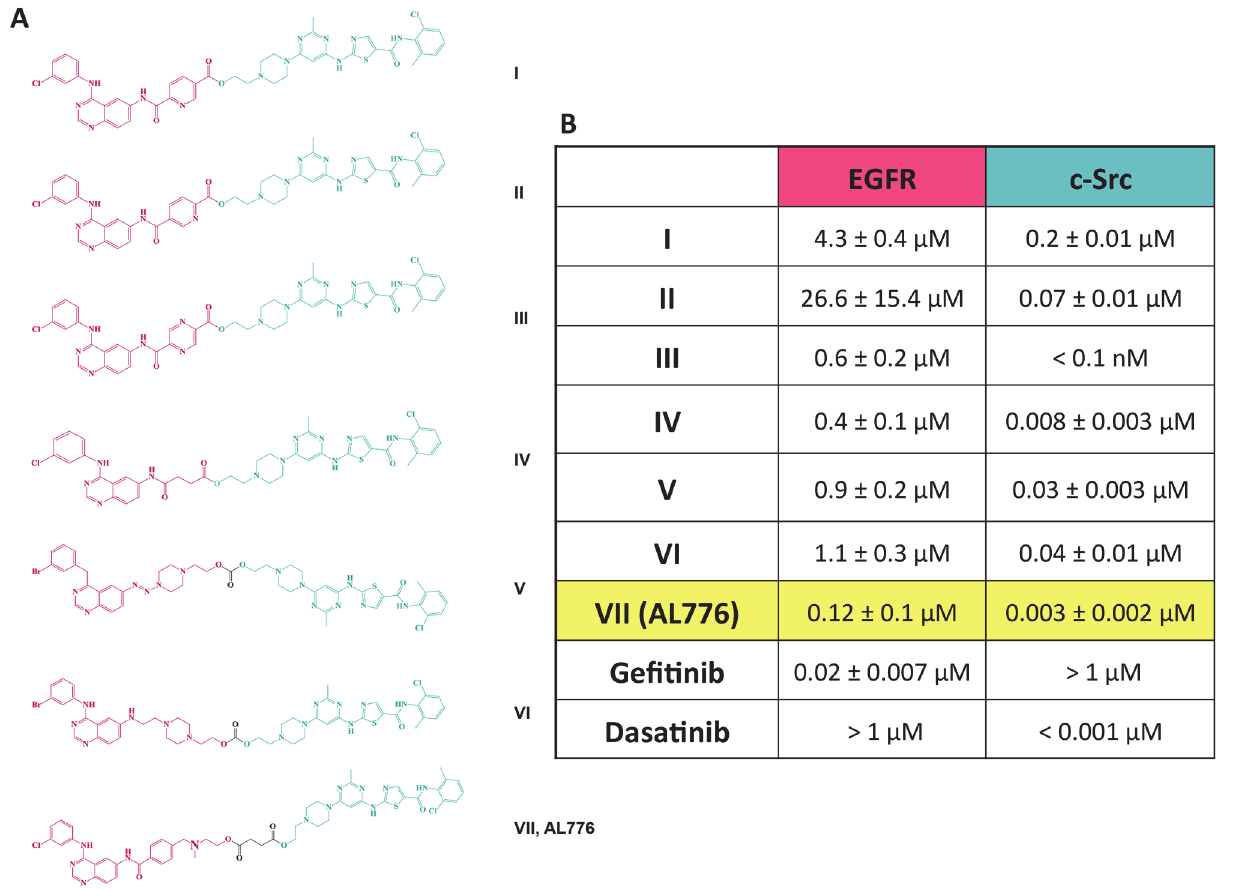
Fig 2. Series of EGFR-c-Src targeting type III molecules and their kinase inhibitory potency in vitro . ( A ) EGFR-c-Src targeting type III molecules were designed and synthesized in our laboratory using quinazoline moieties (red) as the EGFR targeting head and dasatinib as the c-Src inhibitory arm (green), connected through different hydrolysable linkers. ( B ) In vitro kinase assay was used to determine the potency of each molecule in the series to competitively bind and inhibit the ATP binding pocket of the tyrosine kinase domains of EGFR and c-Src. Gefitinib and dasatinib were used as control drugs for comparison, and the IC 50 values of kinase inhibition were determined using the GraphPad Prism 6.0 software. Each value represents the average IC 50 from three independent experiments, carried out in duplicate.